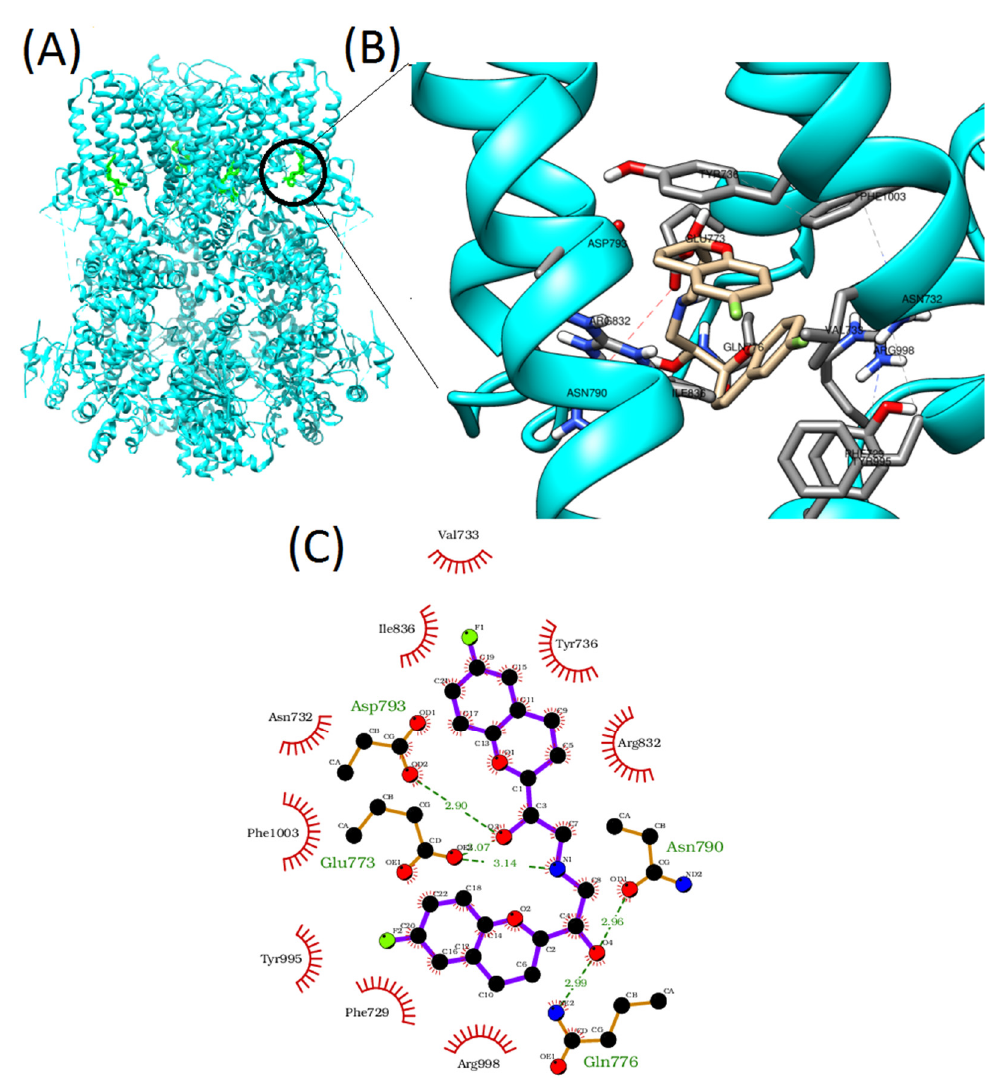
Figure 3. ( A ) Structure of the TRPM8 protein showing the four interaction binding sites, highlighted in green. ( B ) 3D depiction of nebivolol-TRPM8 binding. ( C ) 2D depiction of the intermolecular interactions between TRPM8 and nebivolol. The 2D plots were generated by LigPlot + . Hydrogen bonds are shown as green dotted lines, while the red spoked arcs represent hydrophobic contacts of residues with each drug. In the represented structures, carbon, oxygen, flour, and nitrogen are in black, red, green, and blue, respectively.